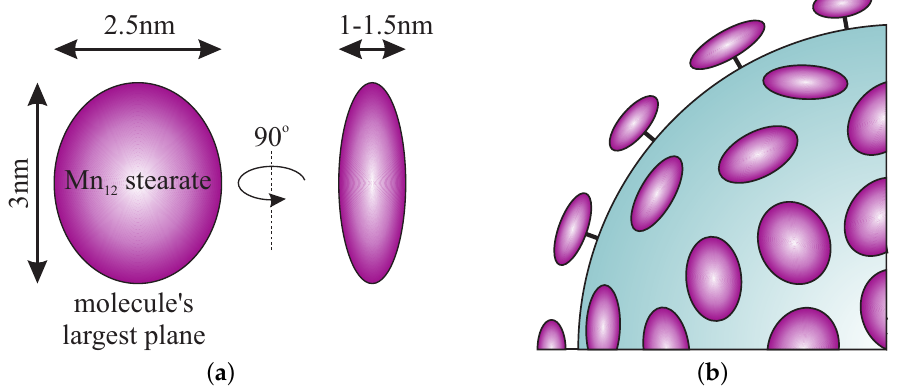
Figure 4. Schematic representation of the geometry of Mn 12 -stearate single-molecule magnets attached to the surface of spherical silica: simplified geometry of Mn 12 -stearate molecule ( a ) and the geometry of molecules anchored to the silica support ( b